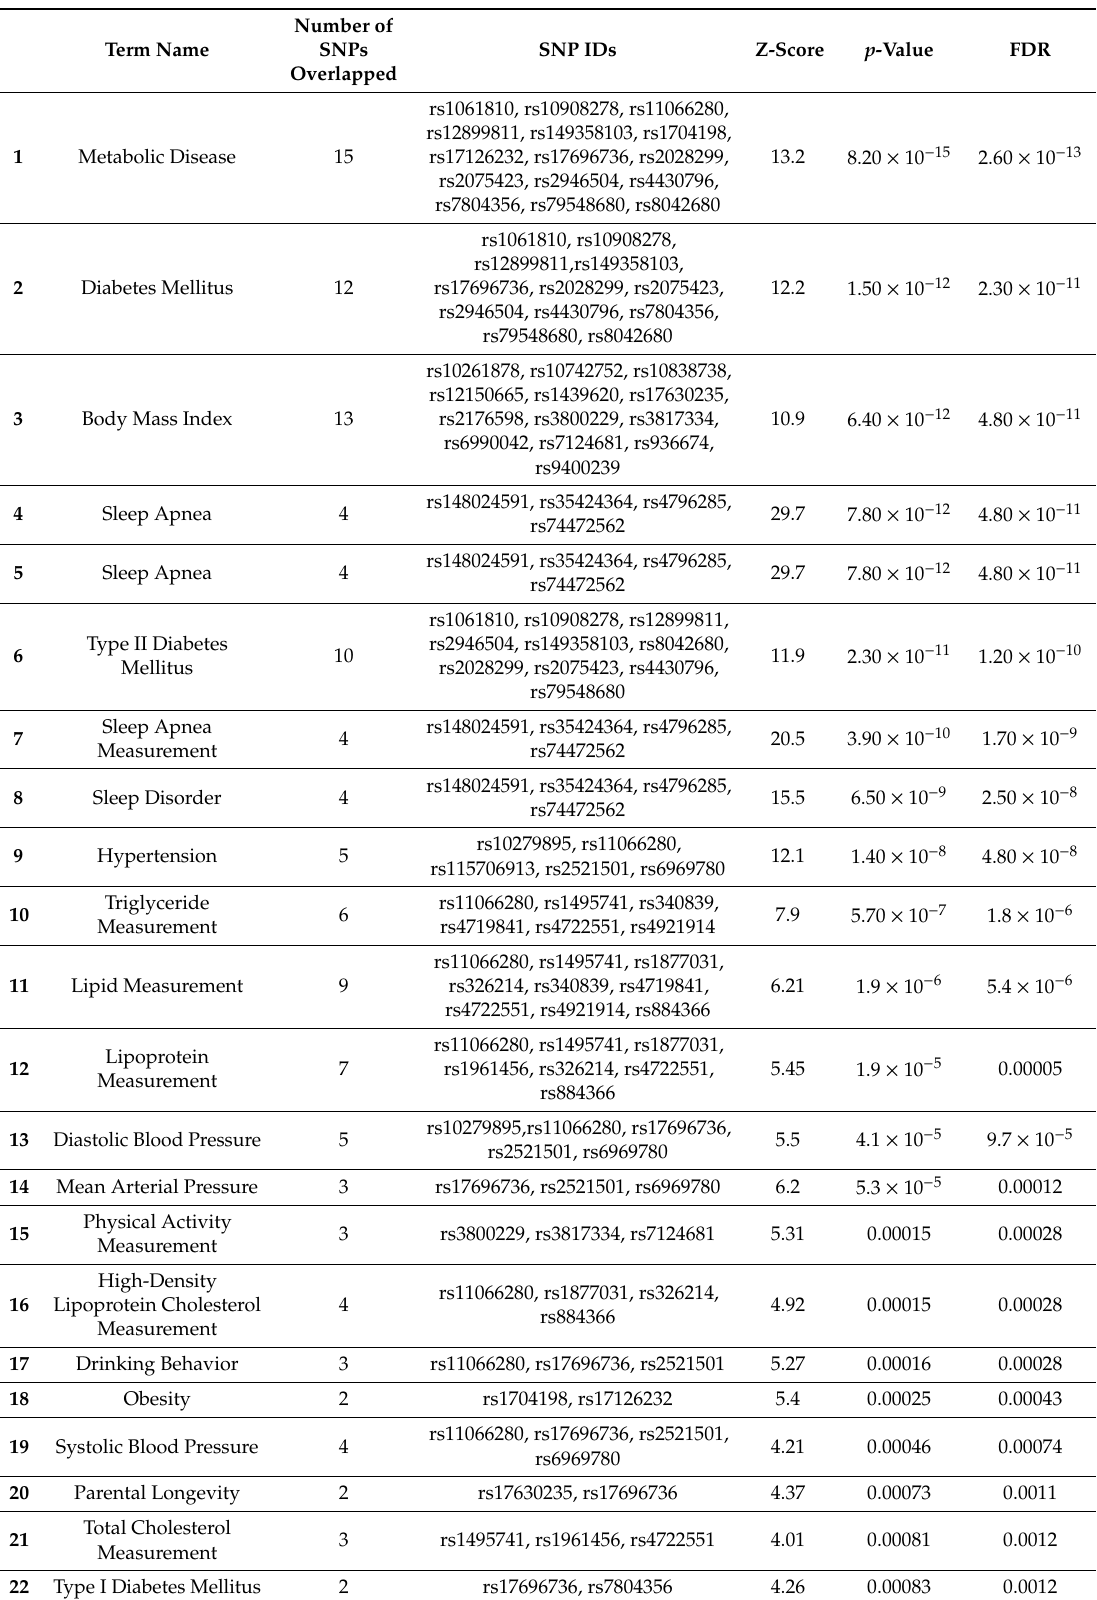
Table 3. Enrichment analysis of the 46 SNPs found in eight shared chromosomal regions in at least four of the